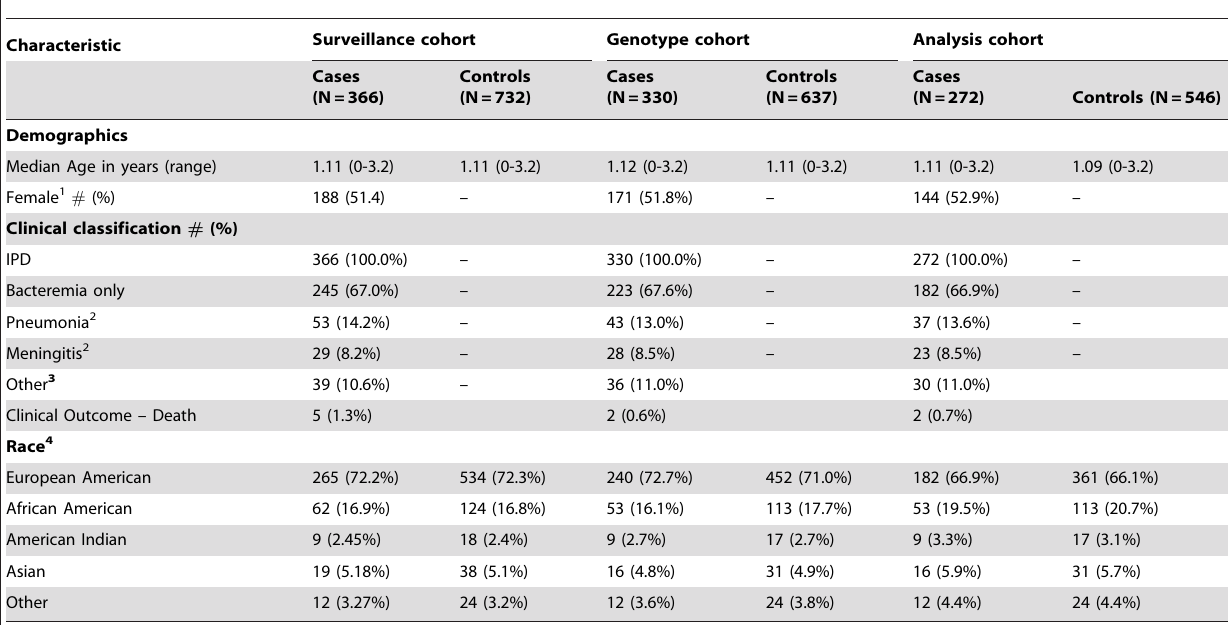
Table 1. Study Population